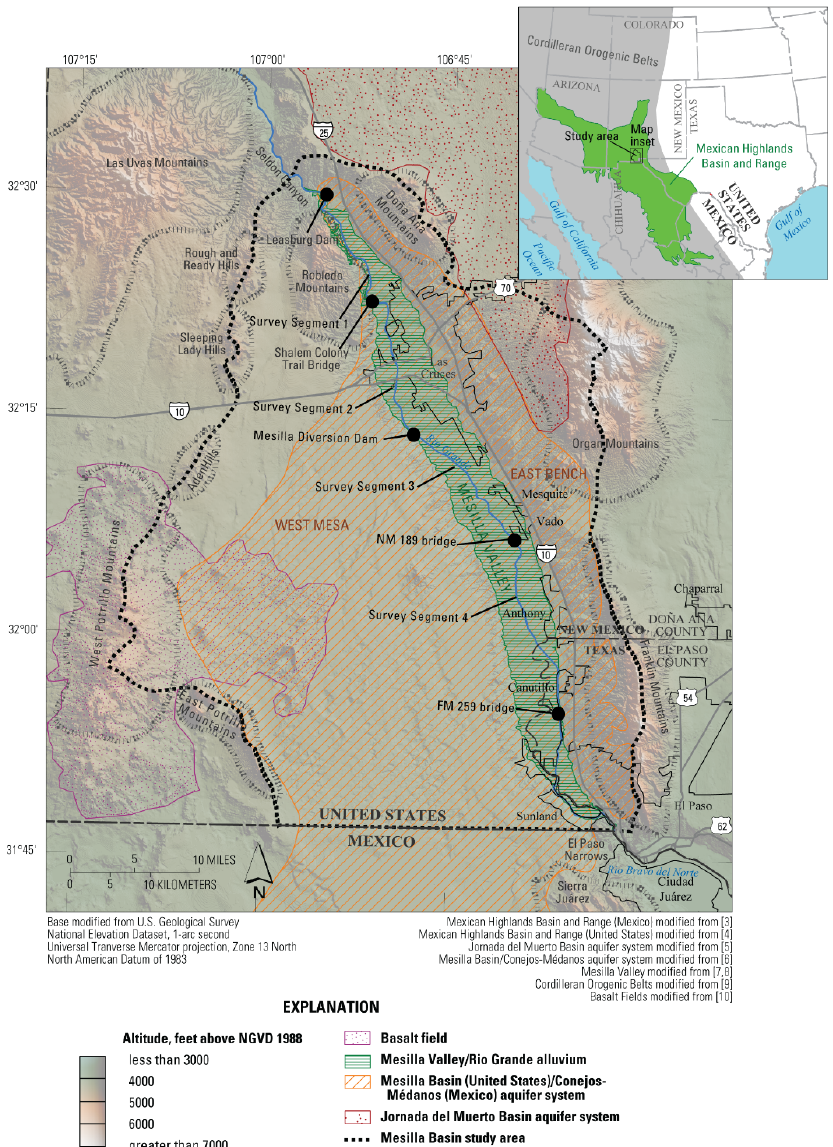
Figure 1. Location map of the entire surveyed reach of the Rio Grande across the Mesilla Valley in Doña Ana County, New Mexico (N. Mex.) and El Paso County, Texas (Tex.). The surveyed reach began at Leasburg Dam, N. Mex., and ended downstream at the Farm-to-Market (FM) 259 bridge in Canutillo, Tex., and was divided into survey segments 1–4. Modified from Figure 3 in [2], [3– 10].